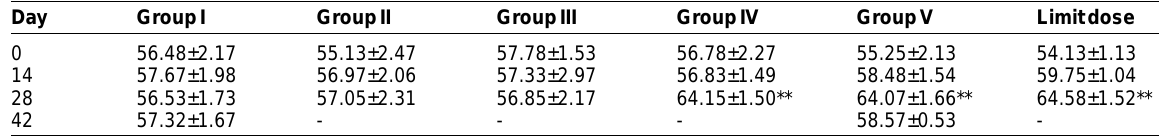
Values are Mean±SEM, ** P<0.01, n=6, the values on day 42 pertain to satellite group Table-3. Levels of blood urea nitrogen BUN (mg/dl) in rats fed with S. laurifolius leaf extract in repeated dose 28 day oral toxicity study Day